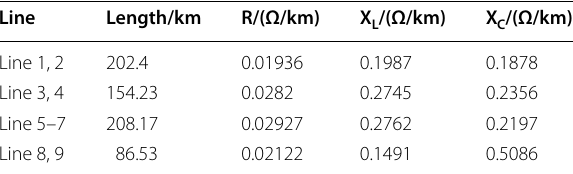
Table 4 Unit parameters of the transmission